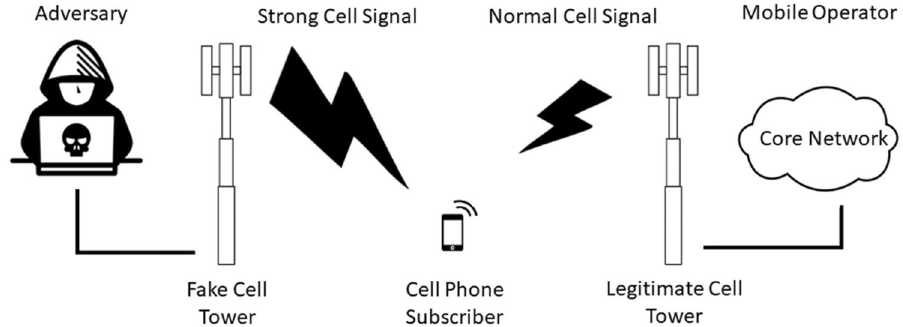
Fig. 2 Fake cell